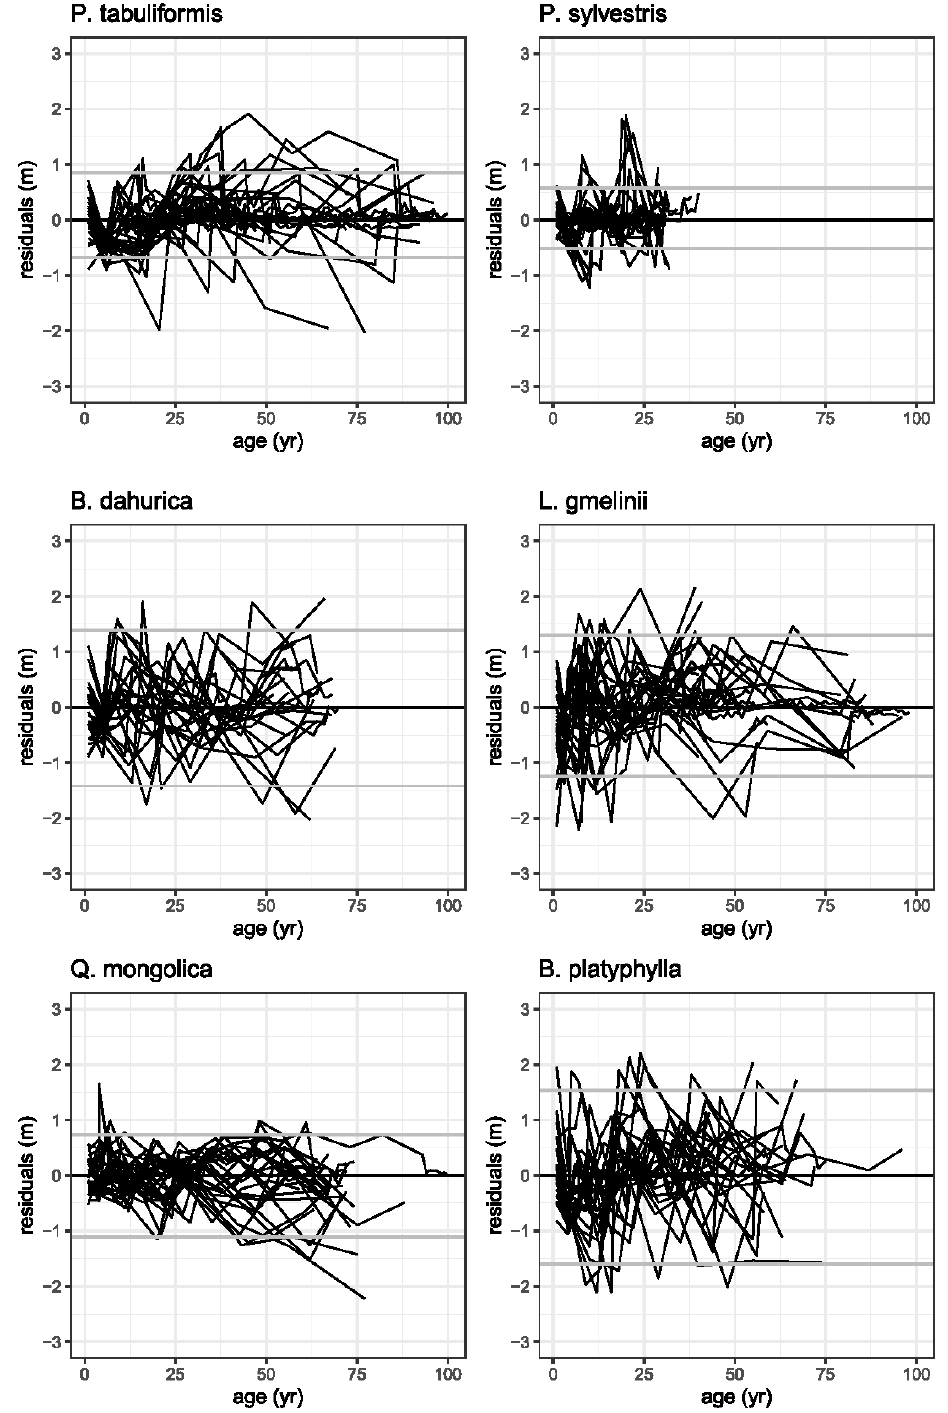
Figure 3. Illustration of the residuals (m) for each tree species. The horizontal grey lines represent the 2.5th and the 97.5th percentiles of a standard normal distribution.